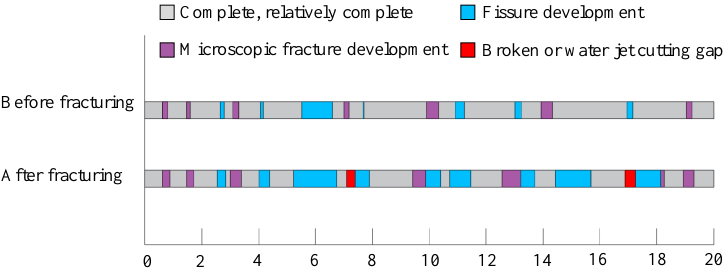
Figure 21. Sketch of fracture development before and after fracturing.